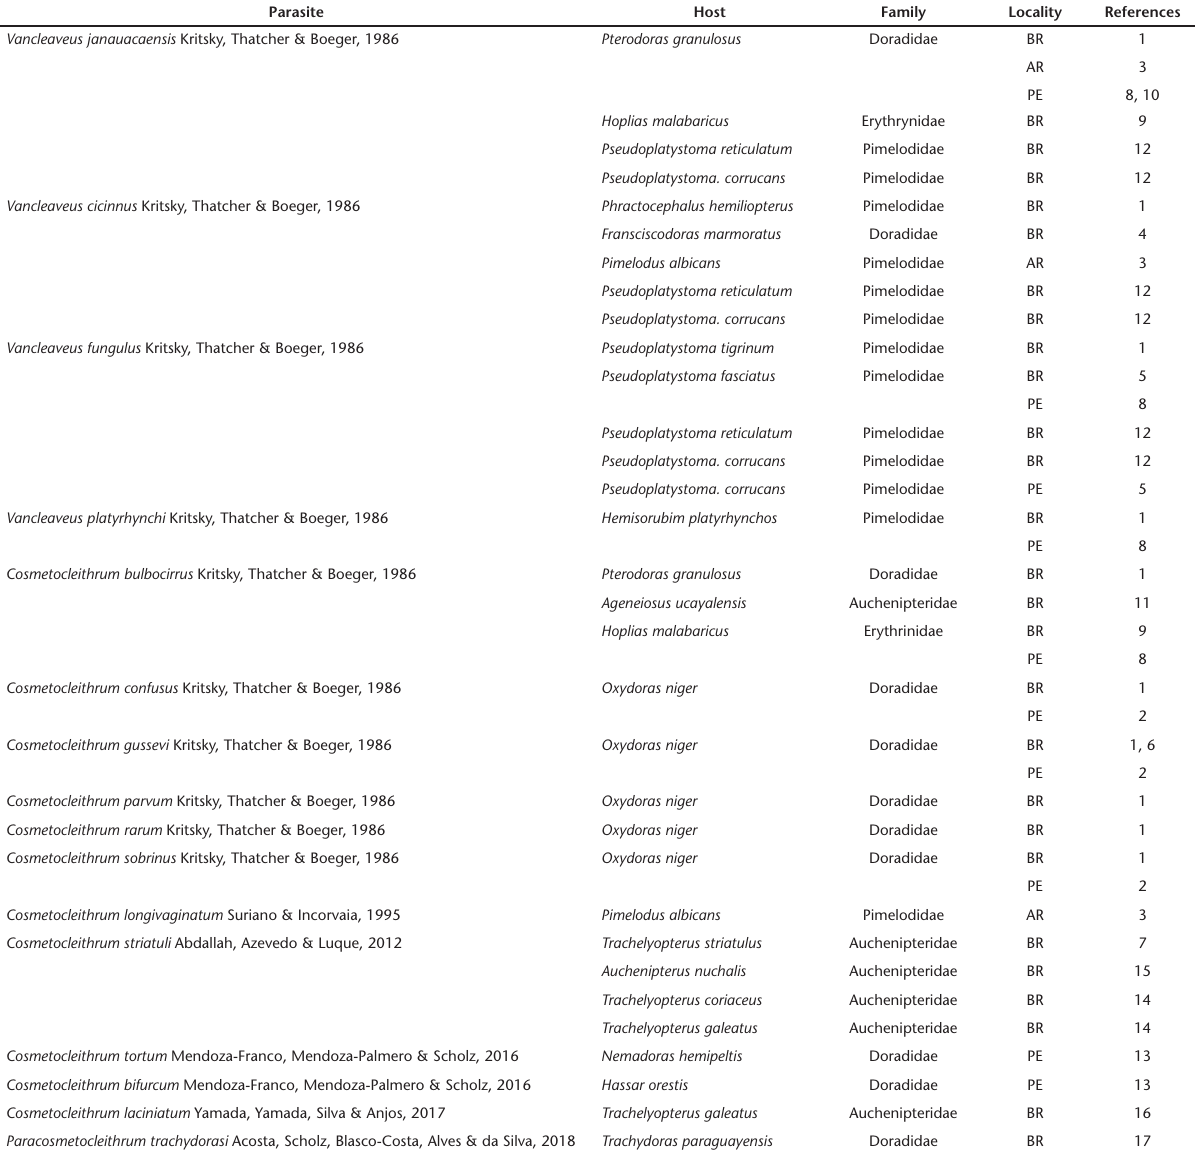
Table 1. List of parasite species of Vancleaveus and Cosmetocleithrum , hosts species, host family, locality and references. AR = Argentina, BR = Brazil, PE =